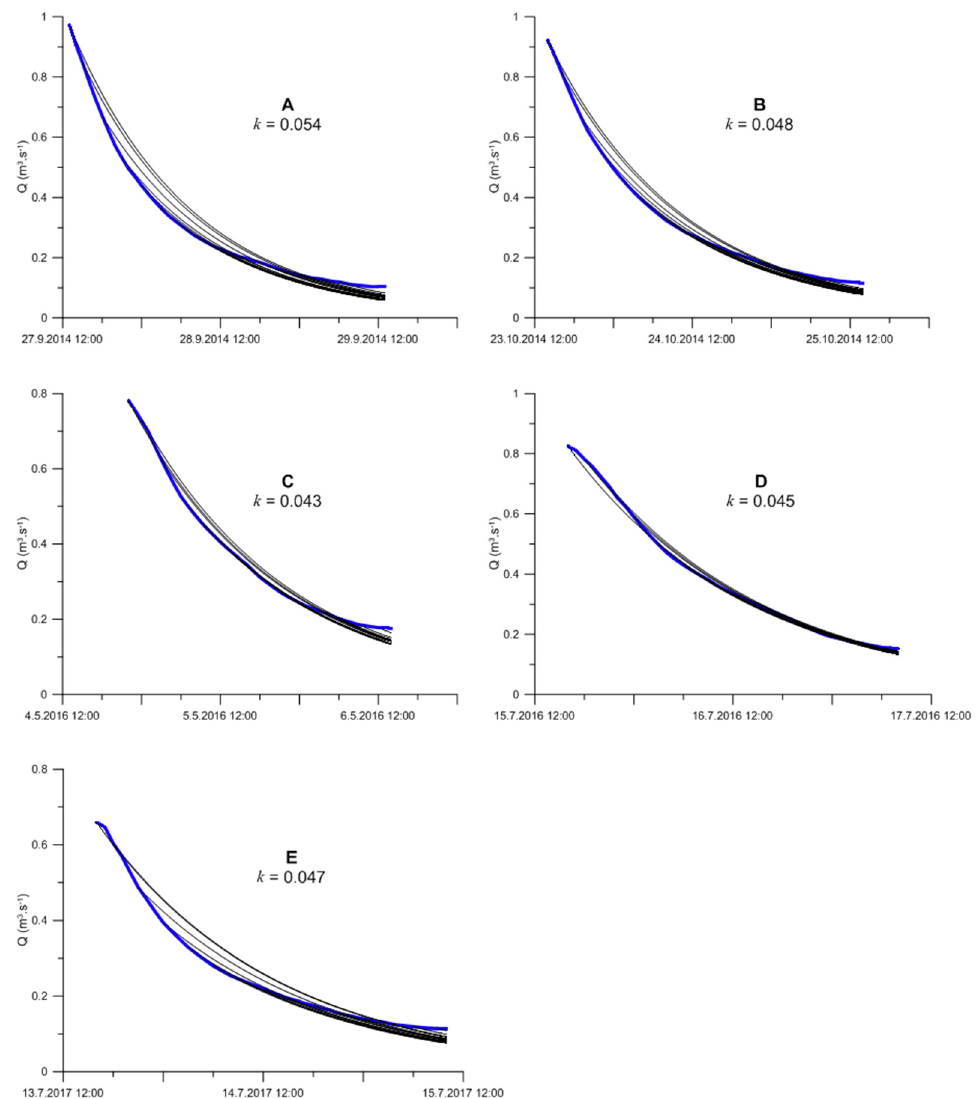
Figure 3. Plot of measured discharges (blue line) and discharges simulated using the value of recession constant averaged for single events for different starting points on the falling limb (black lines). Letters A to E relates to single events (see Table